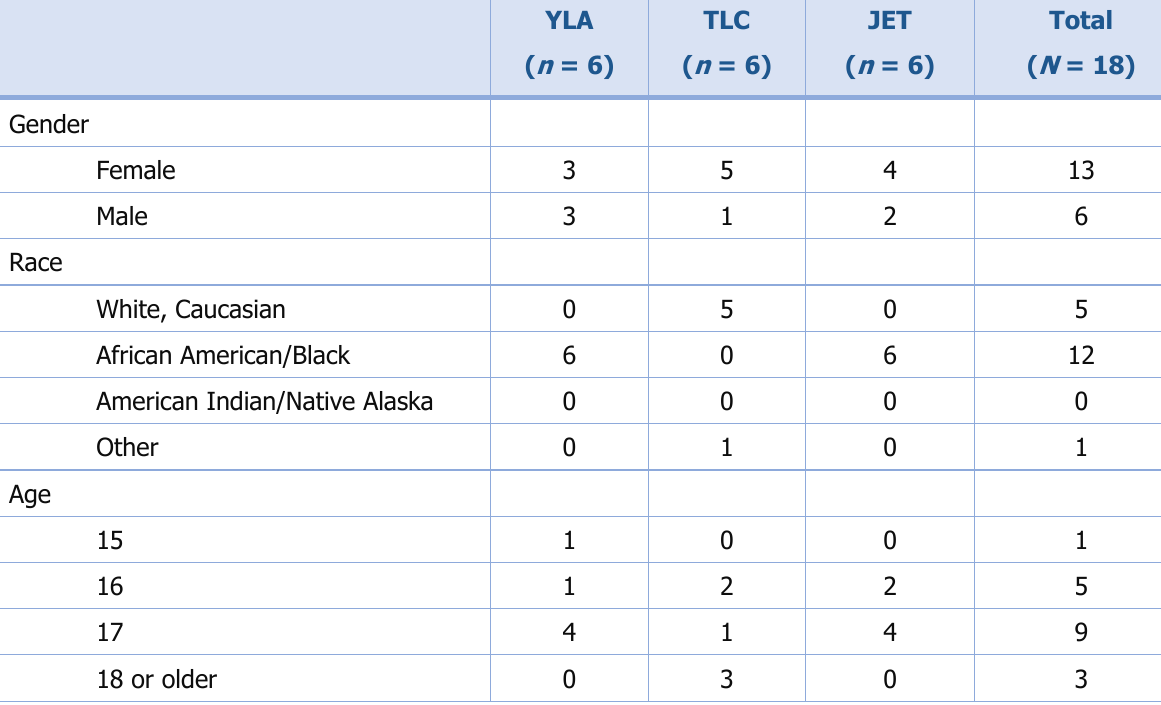
Table 2. Youth Demographics of Focus Group